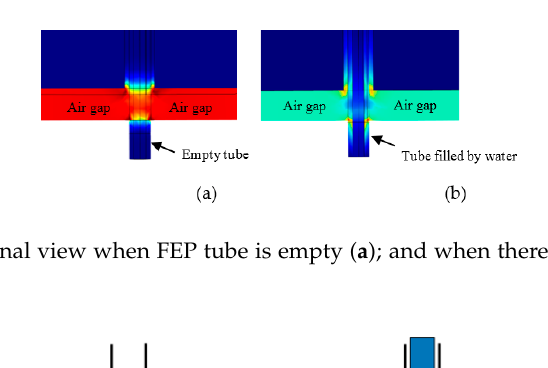
Figure 8. Simulation result for the normalized electric field (V/m) when there is water in the FEP tube within the active gap area.